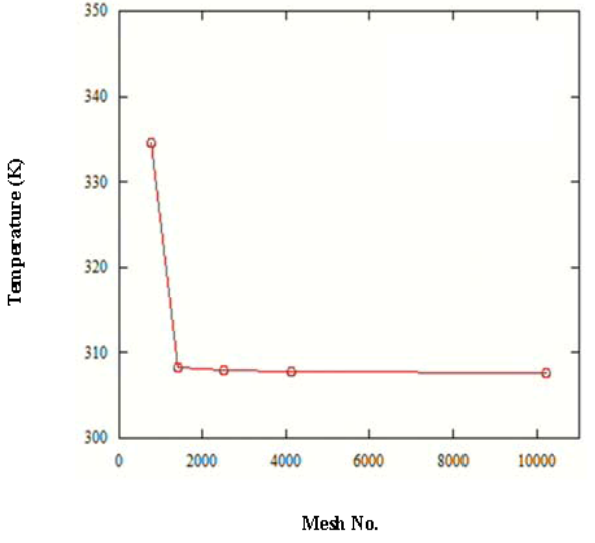
Figure 4. Mesh analysis of the model of the micro multi ‐ channel.